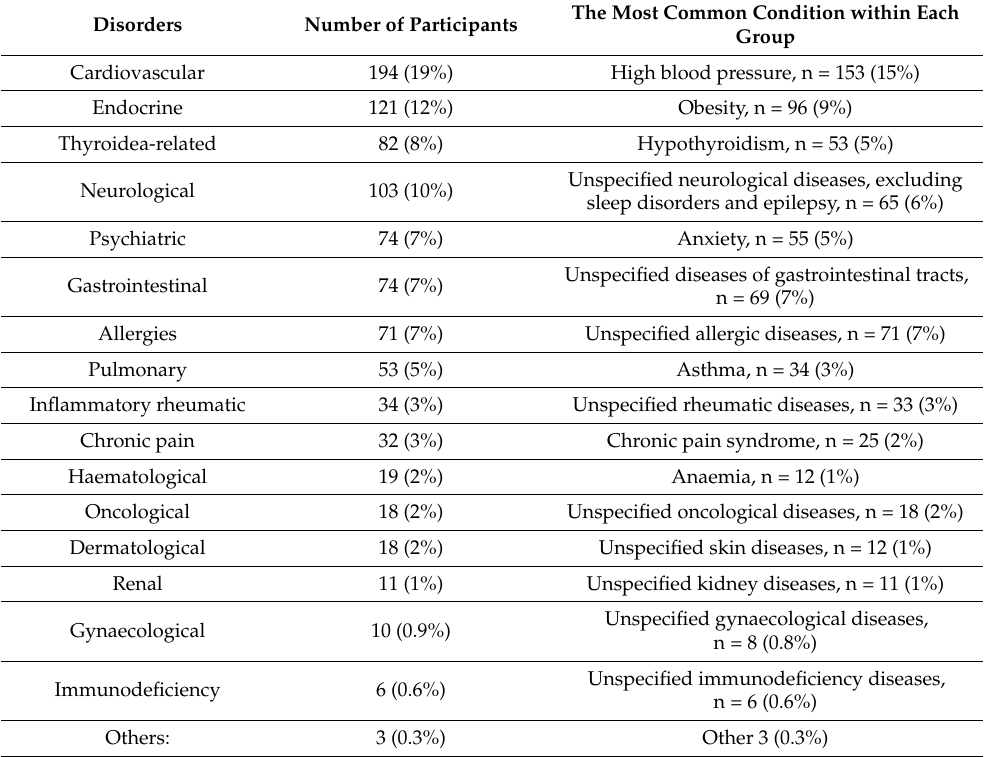
Table 2. Disorders presented as the number of participants and percentage of the whole population (in brackets). The total population was 1050